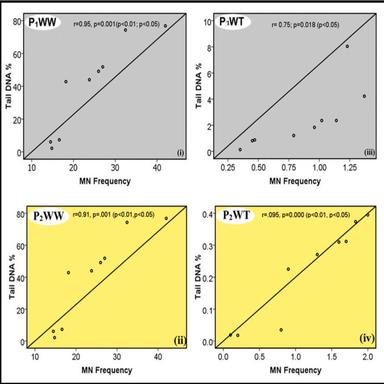
Correlation analysis between MN Frequency and % Tail DNA in the gill cells of zebra fish (Mean � S.D) for (i) P1WW; (ii) P2WW; and (iii) P1WT; (iv) P2WT samples.